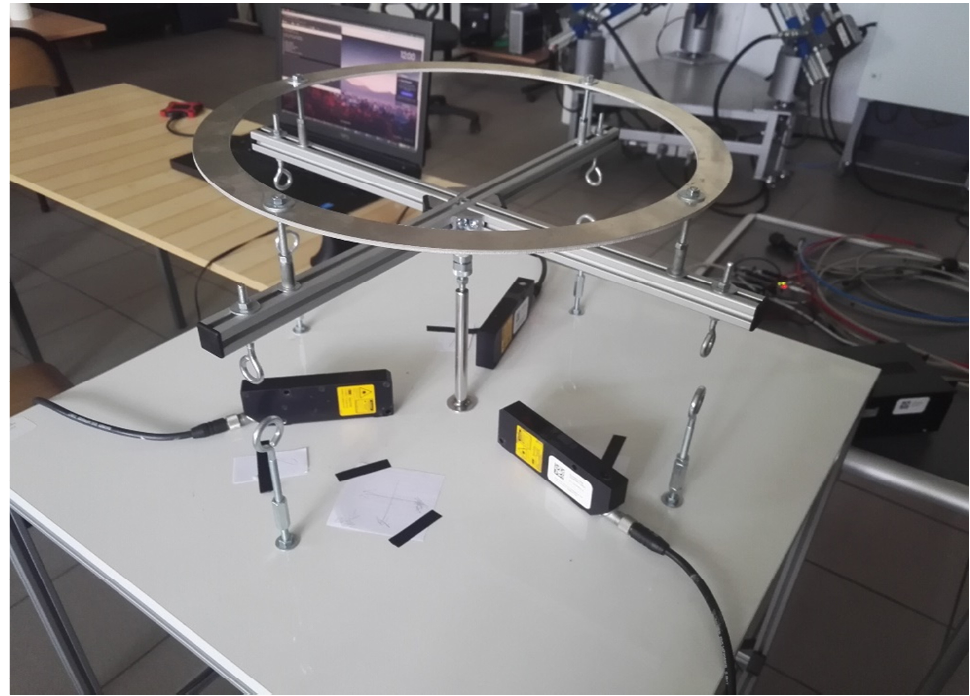
Figure 1. Test-bench for drones.